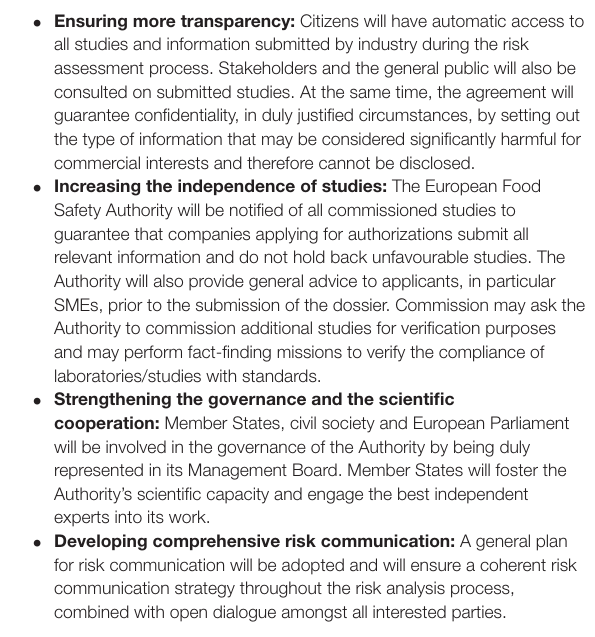
BOX 2 | The four main elements of the New Regulation agreement aim